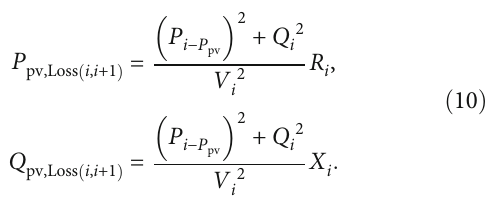
Table 3: Current distortion limits for system rated 120 V to 69kV. Maximum harmonic current distortion in percent of I Individual harmonic order (odd